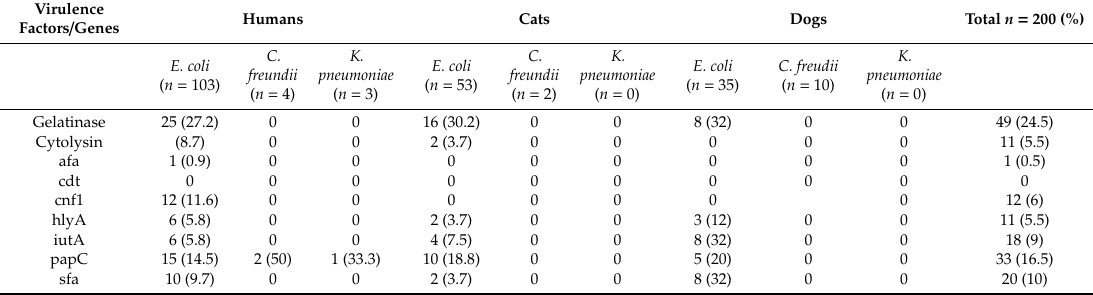
Table 6. Frequency of virulence factors and genes (%) among faecal E. coli , C. freundii , and K. pneumoniae isolated from human, cat, and dog